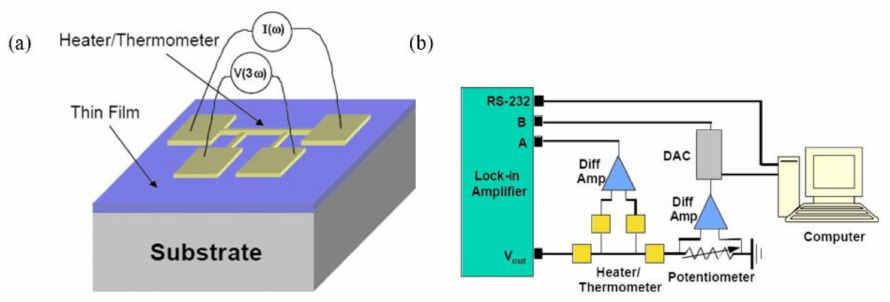
Figure 3. Schematic diagram of ( a ) 3 ω method. ( b ) experimental circuit. Reprinted with permission from Ref. [33]. Copyright 2008, AIP